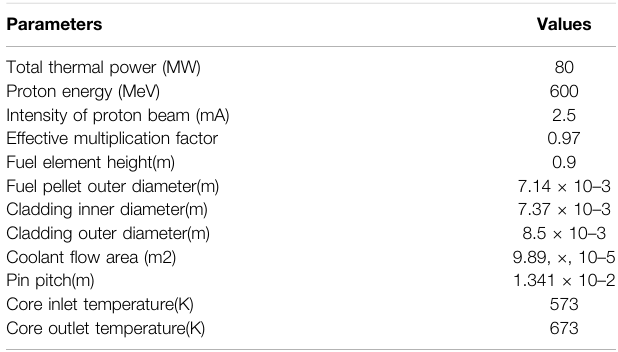
TABLE 2 | Main design parameters of the ADS